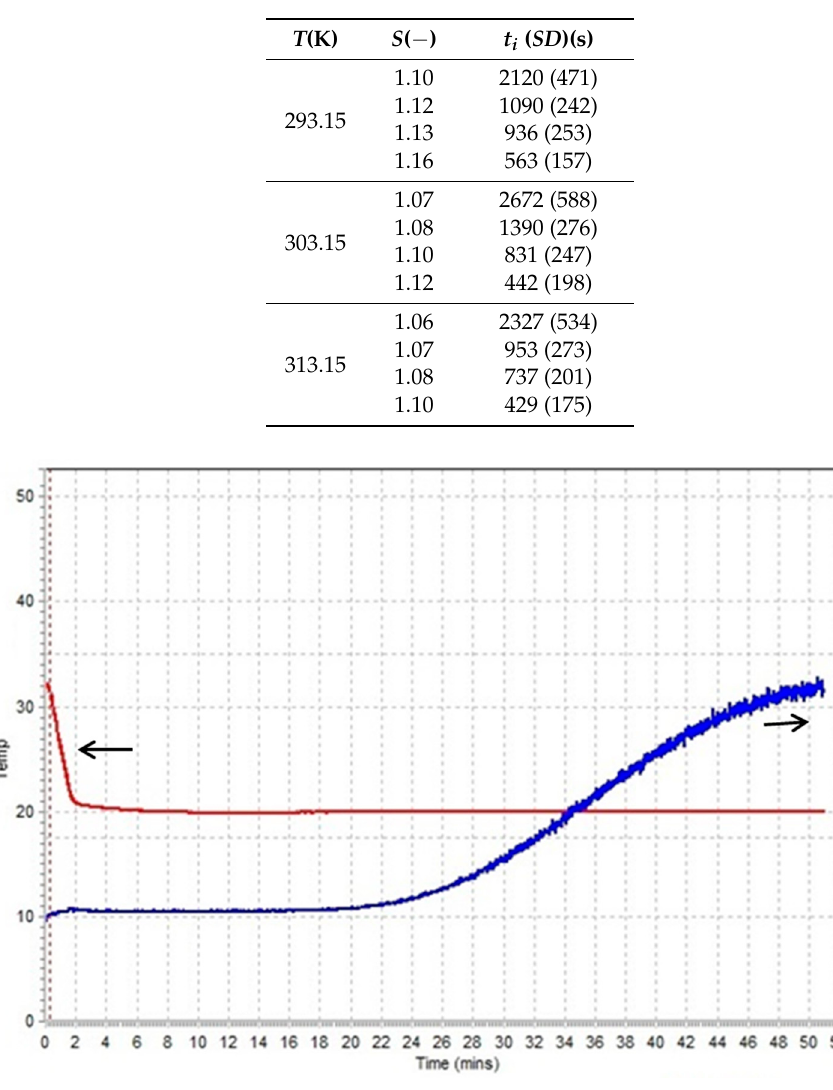
Figure 1. The variation of measured turbidity with time for S = 1.15 and 293.15 K.